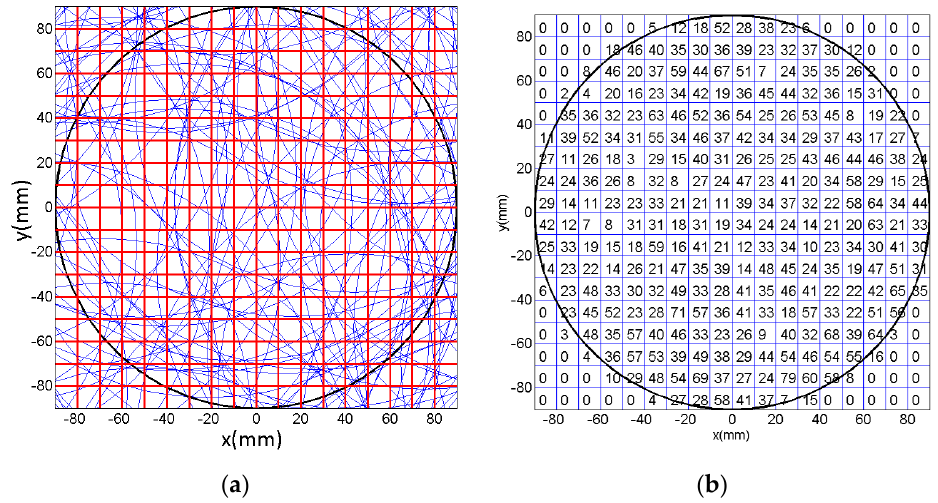
Figure 9. ( a ) Schematic representation of the divided squares on the surface of workpiece and ( b ) the total number of trajectories passing over each square at at i pw = 1 and lapping time t = 6 s.